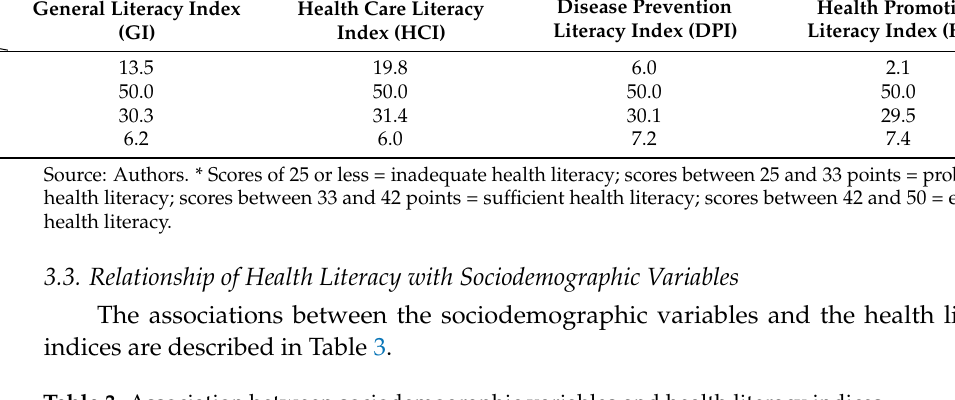
Table 3. Association between sociodemographic variables and health literacy